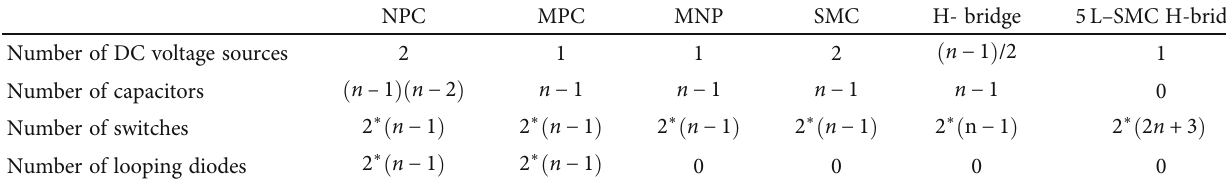
Table 2: Comparison between the fi ve multilevel inverter structures.